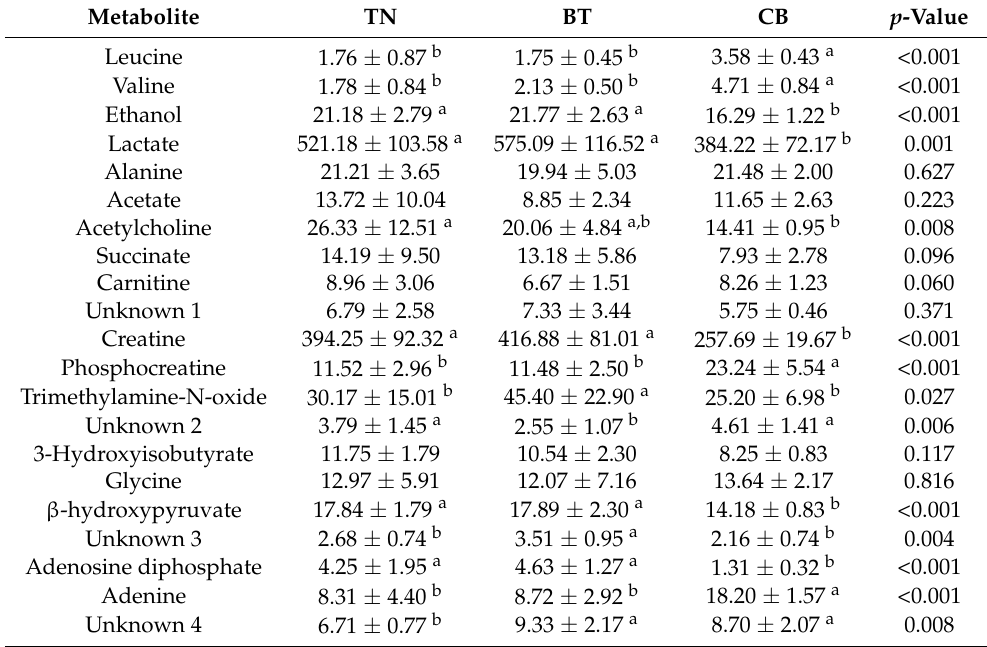
Table 4. Relative concentrations (mAU) of beef metabolites using 400 MHz 1 H-NMR spectra (0–10